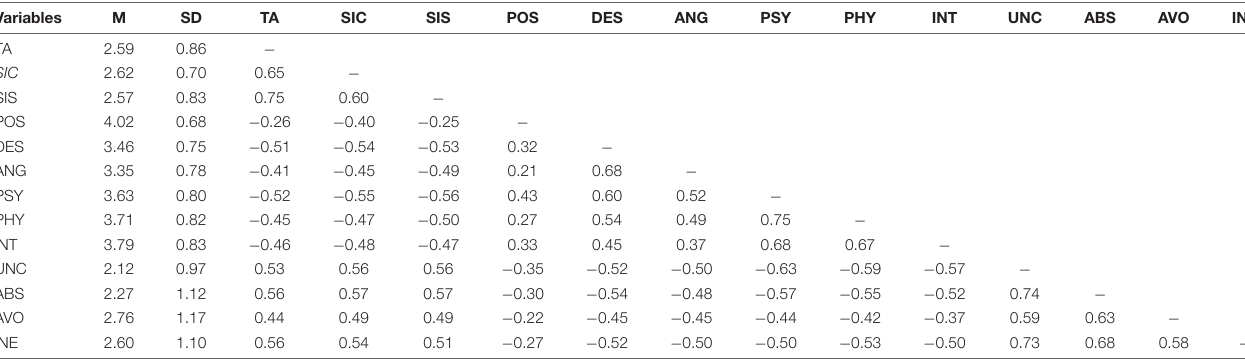
TABLE 2 | Descriptive statistics and correlation between observed variables.